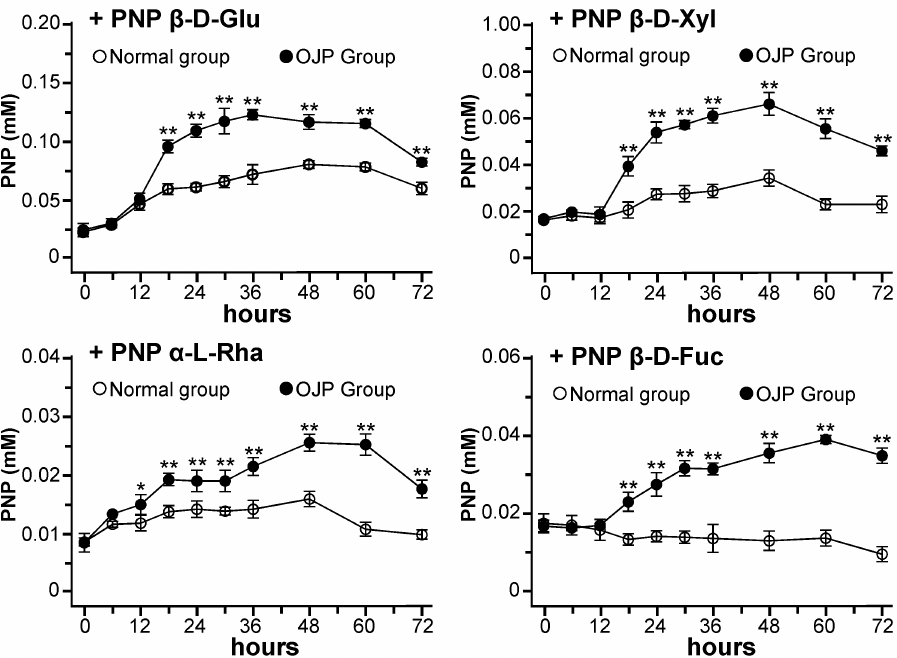
Figure 3. Ophiopogon polysaccharide promote the glycosidase activities of human gut microbiota. Release of PNP after incubation of PNP β -D-Glu, PNP β -D-Xyl, PNP α -L-Rha and PNP β -D-Fuc with human gut microbiota in di ff erent groups were measured in each time points. Normal: ophiopogonin group; OJP: Ophiopogon polysaccharide (OJP) + ophiopogonin group. PNP: p -nitrophenol; PNP β -D-Glu: p -nitrophenyl- β -D-glucopyranoside; PNP β -D-Xyl: p -nitrophenyl- β -D-xylopyranoside; PNP α -L-Rha: p-nitrophenyl- α -L-rhamnopyranoside; PNP β -D-Fuc: p -nitrophenyl β -D-fucopyranoside. Data are represented as mean ± SD ( n = 5). Significance di ff erence was assessed by one-way ANOVA: * p < 0.05 and ** p < 0.01 vs. the normal